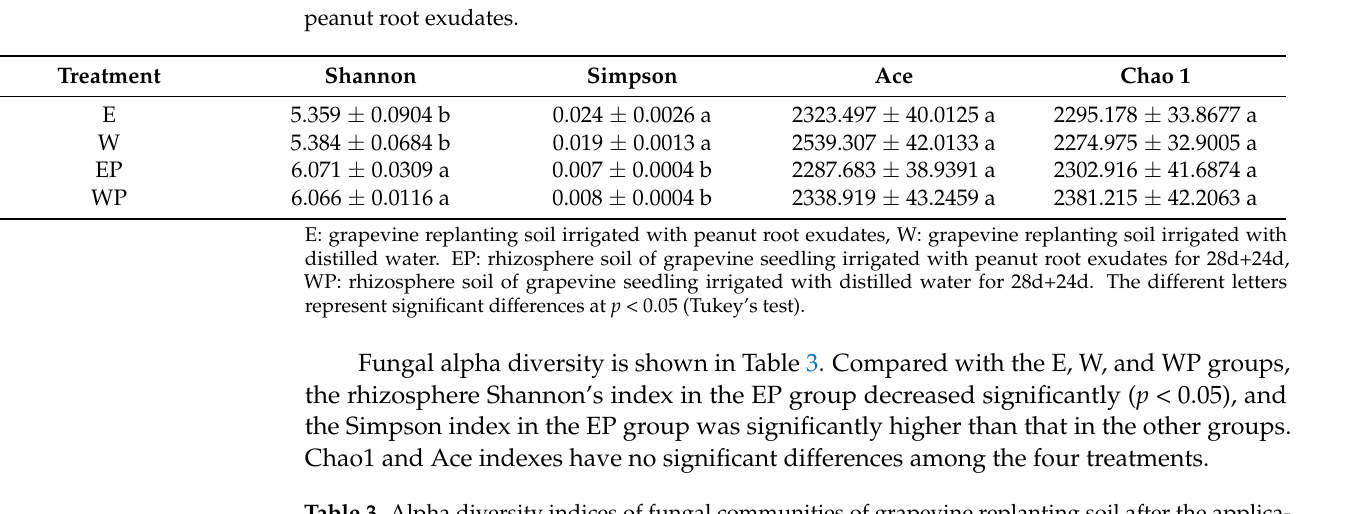
Table 3. Alpha diversity indices of fungal communities of grapevine replanting soil after the applica- tion of peanut root